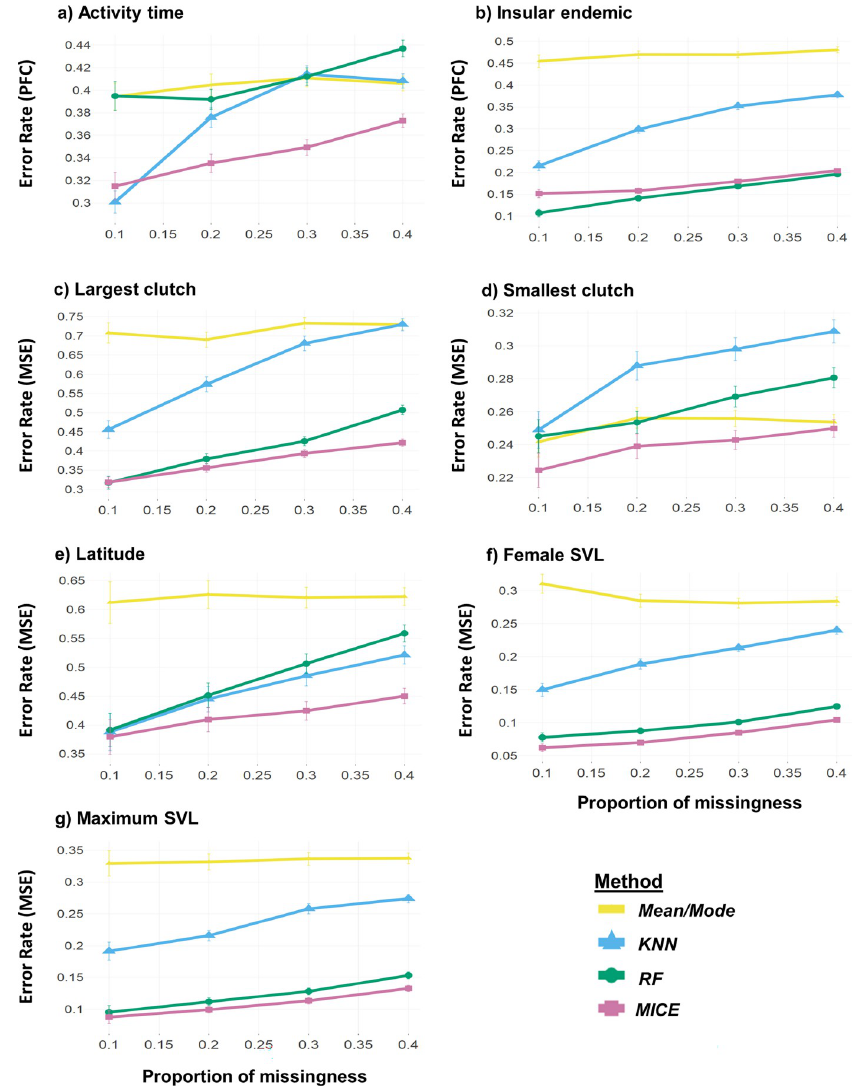
Fig 2. MCAR performance without phylogeny. Performances of the methods mean/mode imputation, KNN , missForest ( RF ), and multivariate imputation by chained equations ( MICE ) across different proportions of missingness when data were missing completely at random (MCAR). For MICE, logistic regression and predictive mean matching were used for imputing categorical and numerical traits, respectively. Error rate was measured as proportion falsely classified (PFC) for the categorical traits a) activity time and b) insular endemic and as mean squared error (MSE) for the numerical traits c) largest clutch, d) smallest clutch, e) latitude, f) female snout-vent length (SVL), and g) maximum SVL. PFC and MSE values for each trait were averaged across 100 dataset replicates. In both cases, error rates closer to 0 are indicative of better performance.